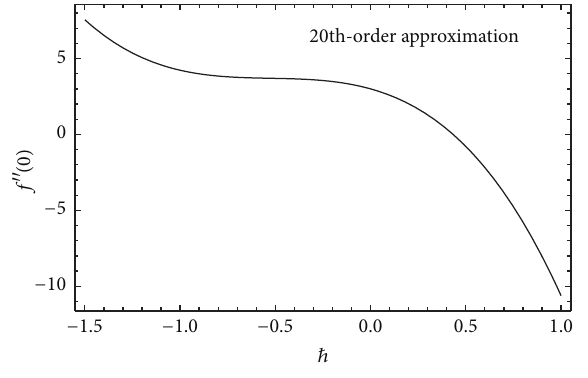
Figure 4: ℎ -curve for 𝑀 = 1, 𝐾 𝑤 = −2 , and 𝛾 = 3 .